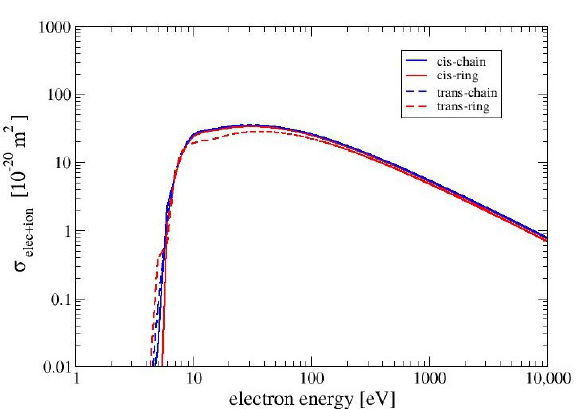
Figure 3. Electronically inelastic cross sections for the four conformers of